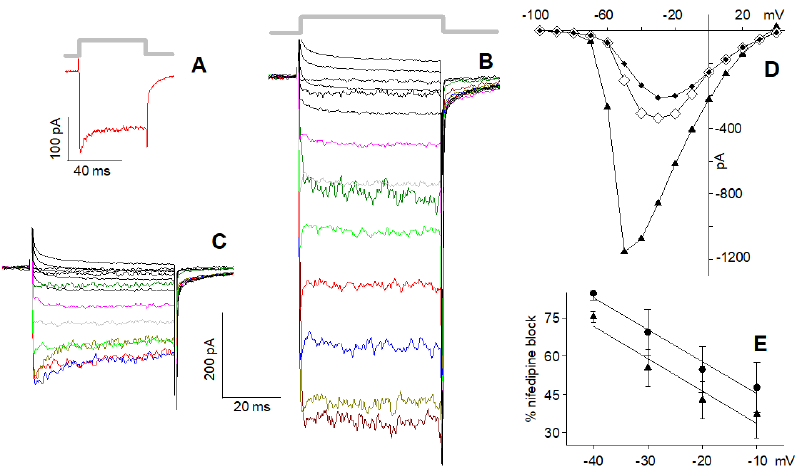
Figure 7. Effect of nifedipine on the L + R1 + R2 cation current in 10 nM Ca 2+ . ( A ) Ca 2+ current evoked by a − 30 mV depolarising step (whose timing is indicated by the thick grey line) in 4 mM Ca 2+ in a cell (recorded in perforated patch) possessing the L, the R1, and the R2 components. ( B ) Cation currents evoked in the same cell (that was exceptionally stable) by the I – V protocol in 10 nM Ca 2+ (whose timing is indicated by the thick grey line, which also applies to panel ( C )). ( C ) Effect of 10 µM nifedipine on the currents in ( B ); ( D ) steady-state I – V relationships obtained from the tracings in ( B ) (triangles) and from the peak (open diamonds) and plateau (filled diamonds) currents in ( C ). ( E ) Average voltage-dependent fractional block operated by nifedipine on the peak (triangles; r = 0.97, slope = − 1.28% per mV, n = 6) and on the plateau (circles; r = 0.98, slope = − 1.26 % per mV, n = 6) of the currents in ( C ). Some current traces in ( B , C ) are coloured with the same